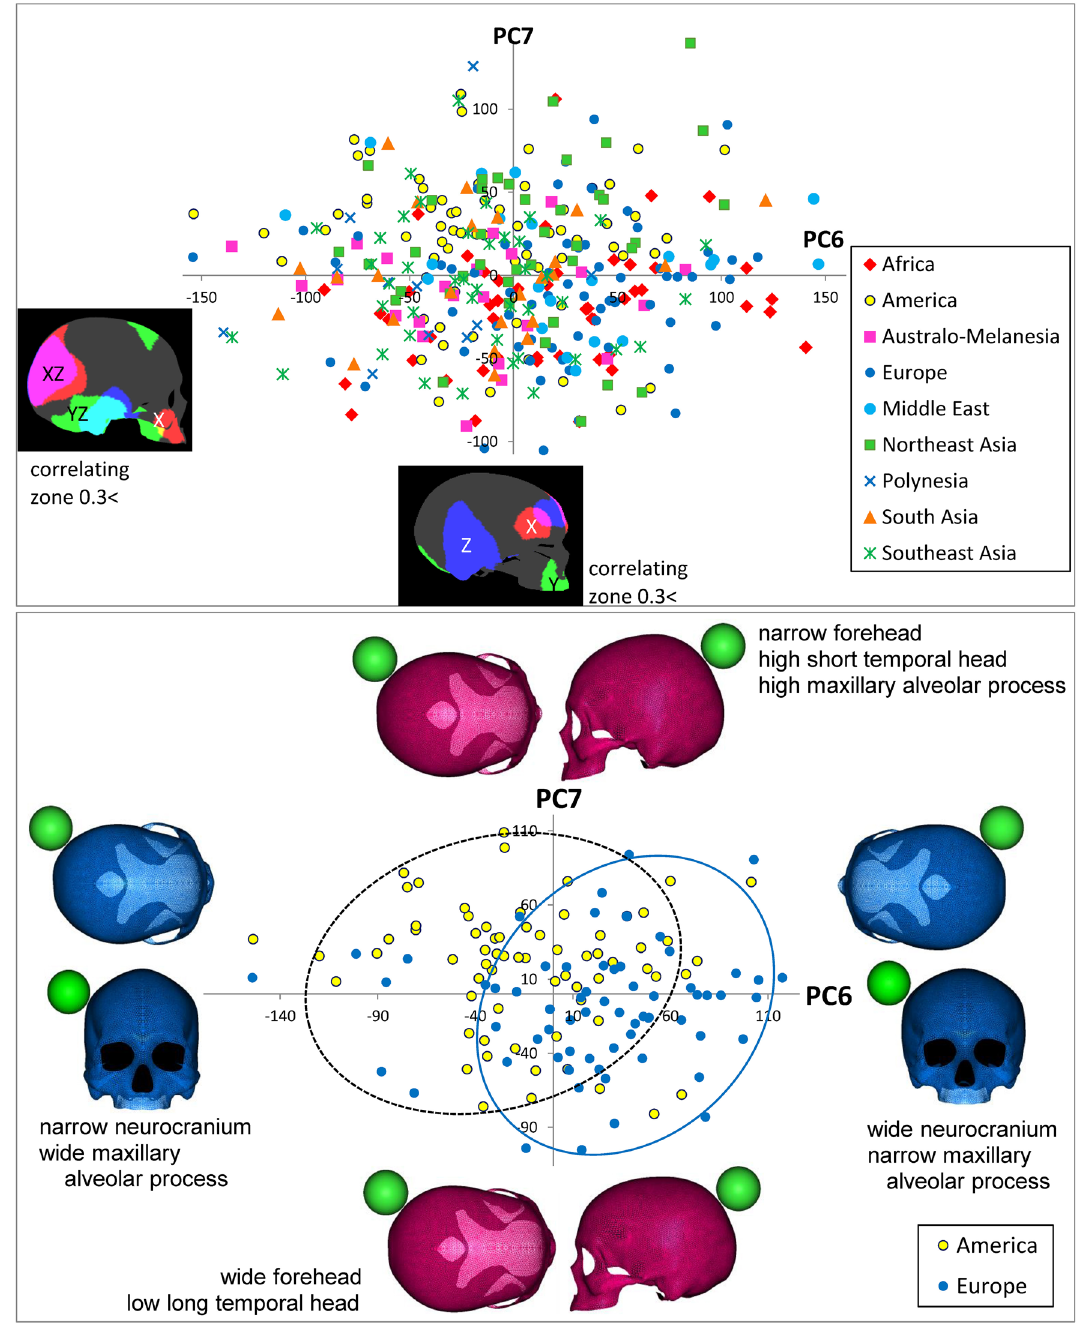
Figure 5. Scatter scoring diagrams of PC6 and PC7 for cranial individuals from nine geographical units (upper), and two geographical units (lower), color maps of cranial surface highly correlating vertices to each PC (interpretation of color against X, Y, Z axis: see text), and virtual shape deformations with a magnitude of 3 SD at the opposite sides of these axes. The scale is given as a green colored sphere of 50 mm in